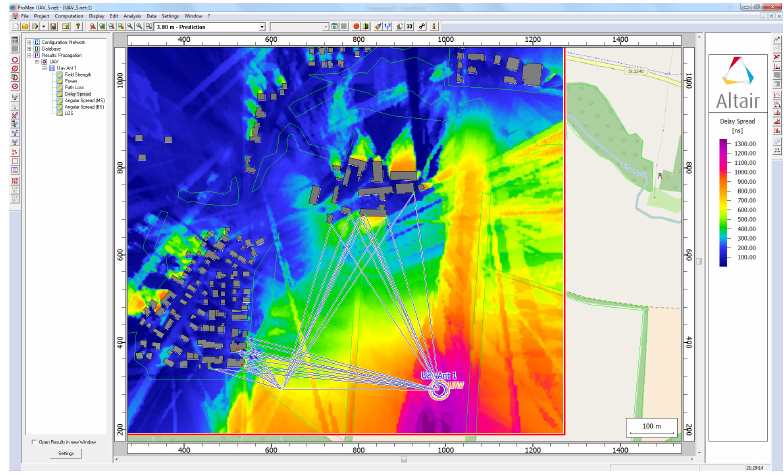
Figure 17. Ray-tracing fingerprints dataset.